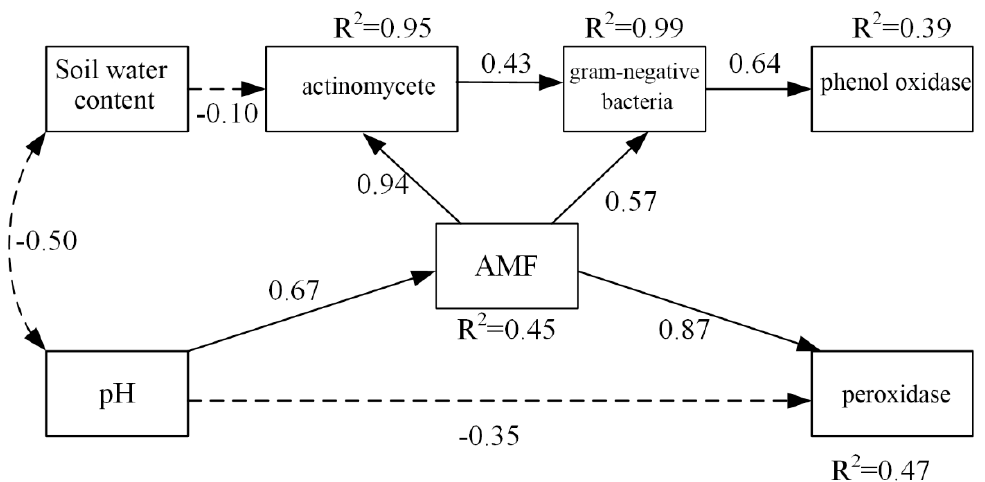
Figure 3. Path of soil oxidase controlled by soil pH, soil water content, and microbial community. AMF: arbuscular mycorrhizal fungi; dash-line arrows indicate negative effects.